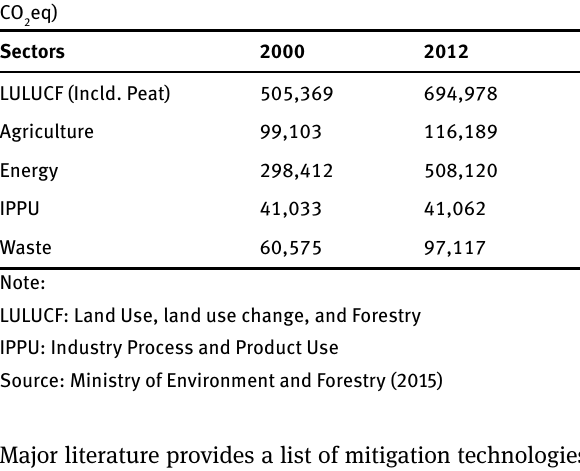
Table 1: Indonesian Emission in 2000 and 2012 (Thousand Tones